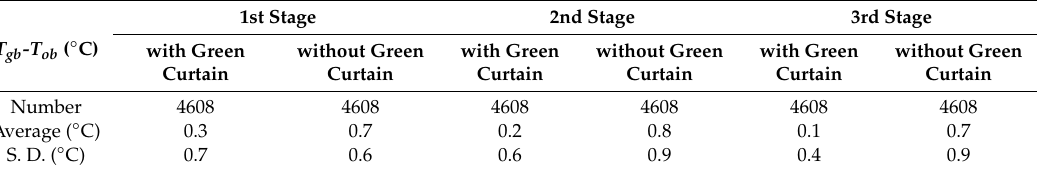
Figure 13. Difference between the balcony globe temperature ( T gb ) and balcony air temperature ( T ob ) with and without green curtain during the measurement period. Table 4. Mean and standard error with green curtain and without green curtain for three stages.